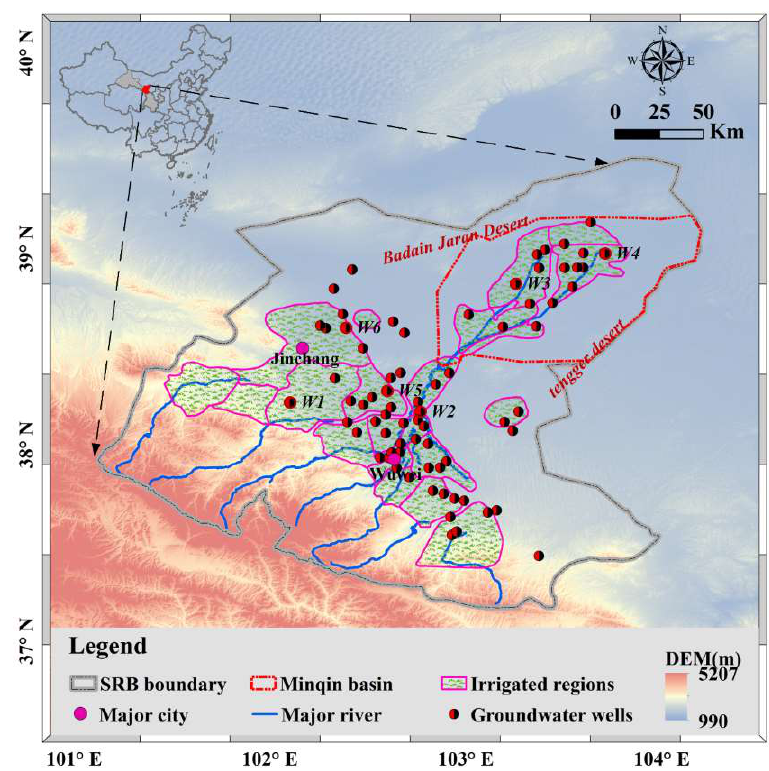
Figure 1. Map of the study area.